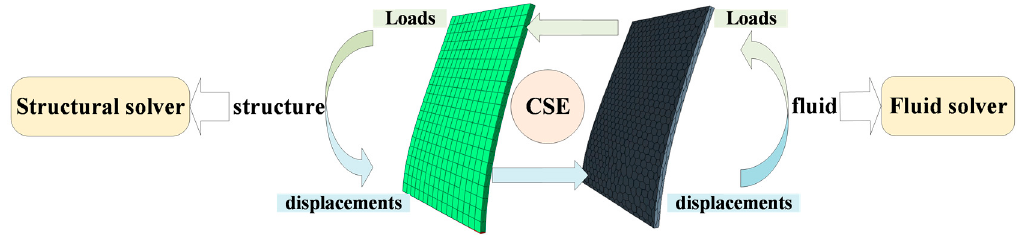
Figure 3. The principle of fluid–structure interaction.